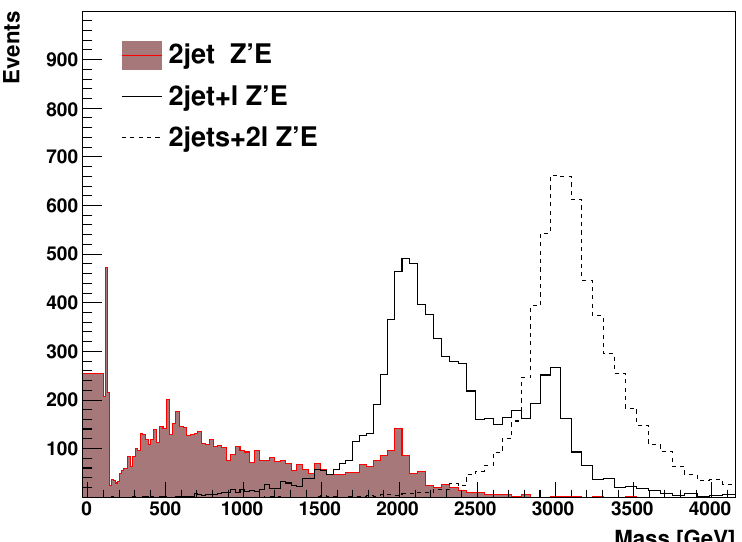
Figure 6. Invariant masses for a Z (cid:48) E model [27] constructed from two jets, two jets plus a lepton and two jets plus two leptons. The Z (cid:48) mass was generated at 3 TeV, while M ( E ) = 2 TeV. The simulations were performed using MG5 with PYTHIA 8